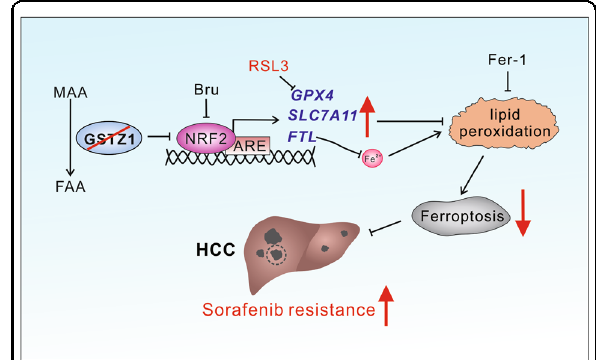
Fig. 8 A proposed model of the resistance of GSTZ1-de fi cient cells to sorafenib. MAA maleylacetoacetate, FAA fumarylacetoacetate, Bru brusatol, ARE anti-oxidation response element, Fer-1 ferrostatin-1, HCC hepatocellular